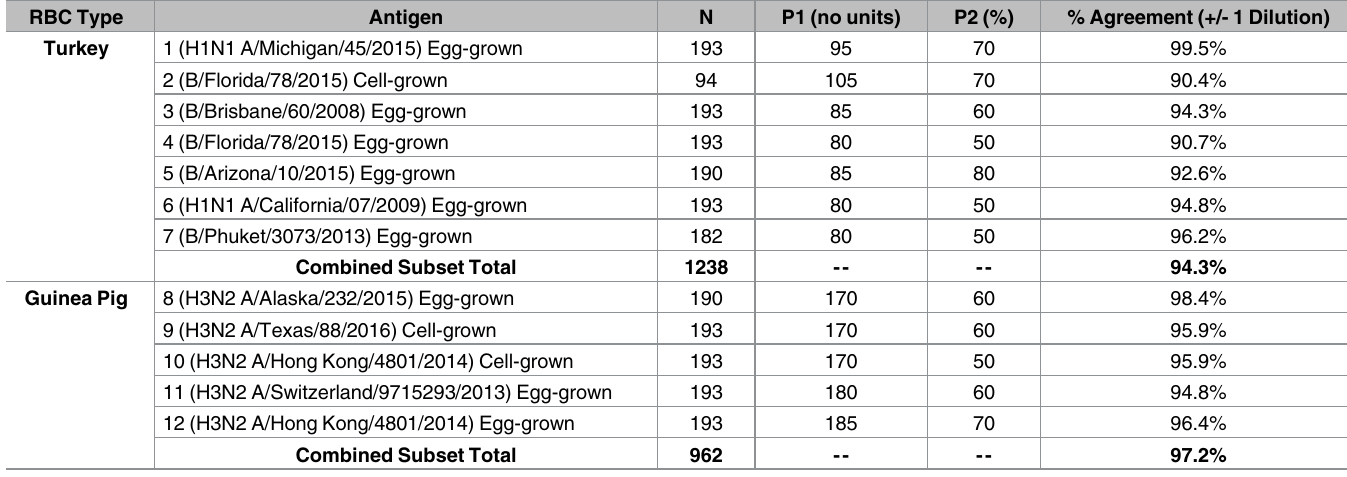
Table 2. Cypher One agreementto expert human